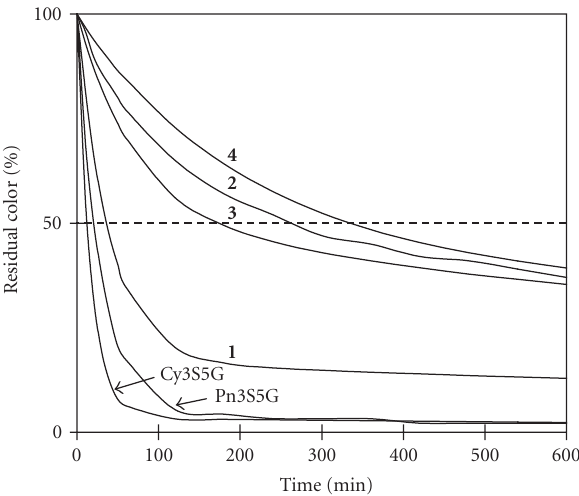
Figure 3. Stability of purple sweet potato callus anthocyanins 1 , 2 , 3 , and 4 in neutral aqueous solution at room temperature.